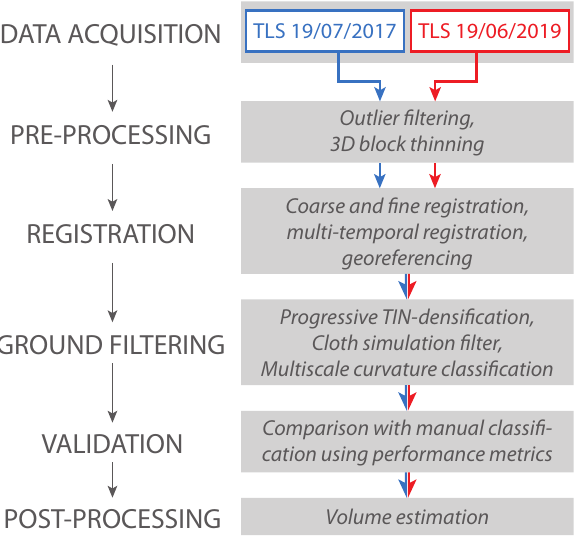
Figure 2. Conceptual workflow of the main processing steps. the centre of a voxel with edge length 0.1 m were kept. Sub- sequently, the acquired 3D point clouds of the two epochs were registered respectively using the Iterative Closest Point al- gorithm (ICP; Besl and McKay, 1992) using flat areas extracted based on the locally computed planarity feature (1 m neighbour- hood; planarity threshold 0.90). Then, the multi-temporal 3D point clouds were registered based on identified bedrock out- crops which are considered stable over time.